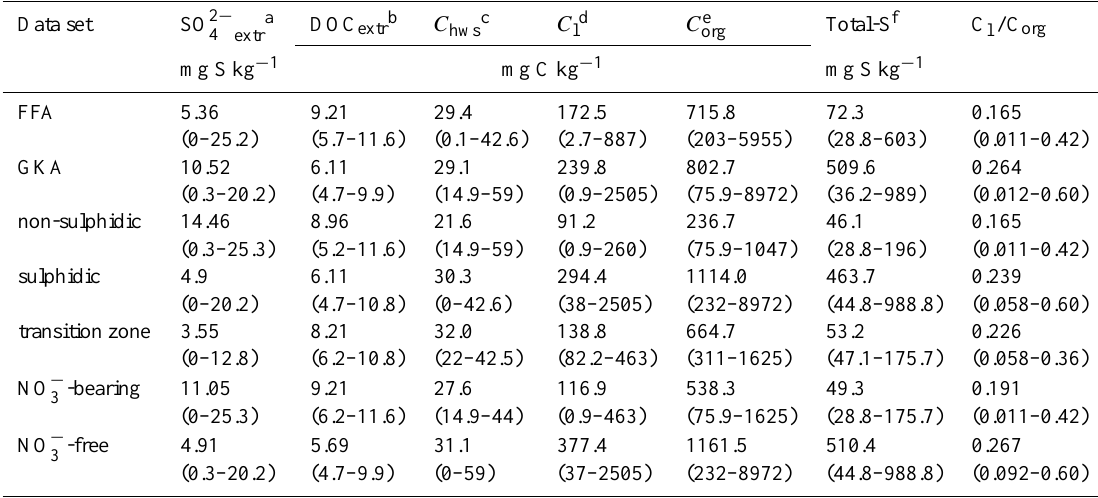
Table 1. Sediment parameters of the incubated aquifer material (medians with ranges in brackets).